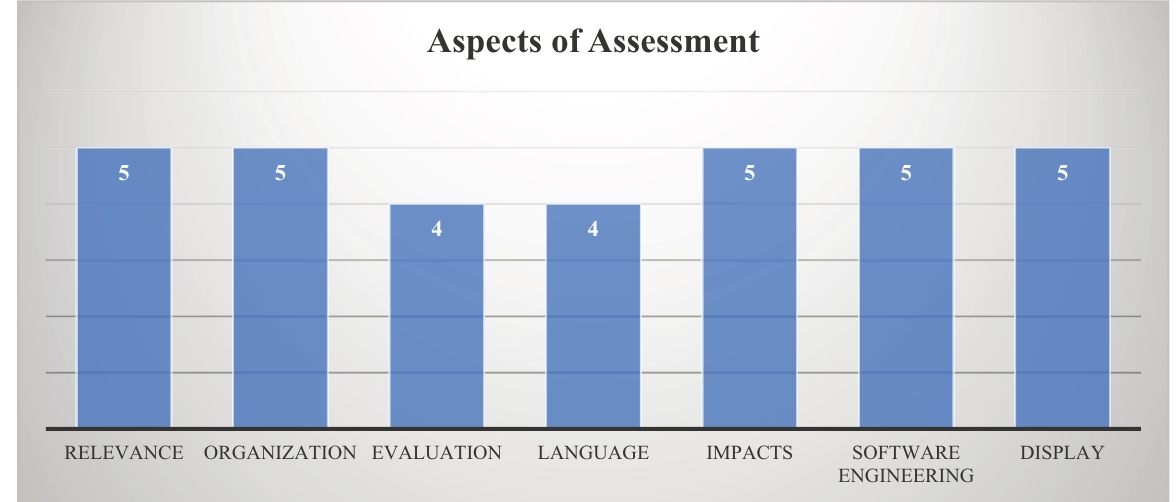
Figure 6: The results of the assessment of the prototype by users.